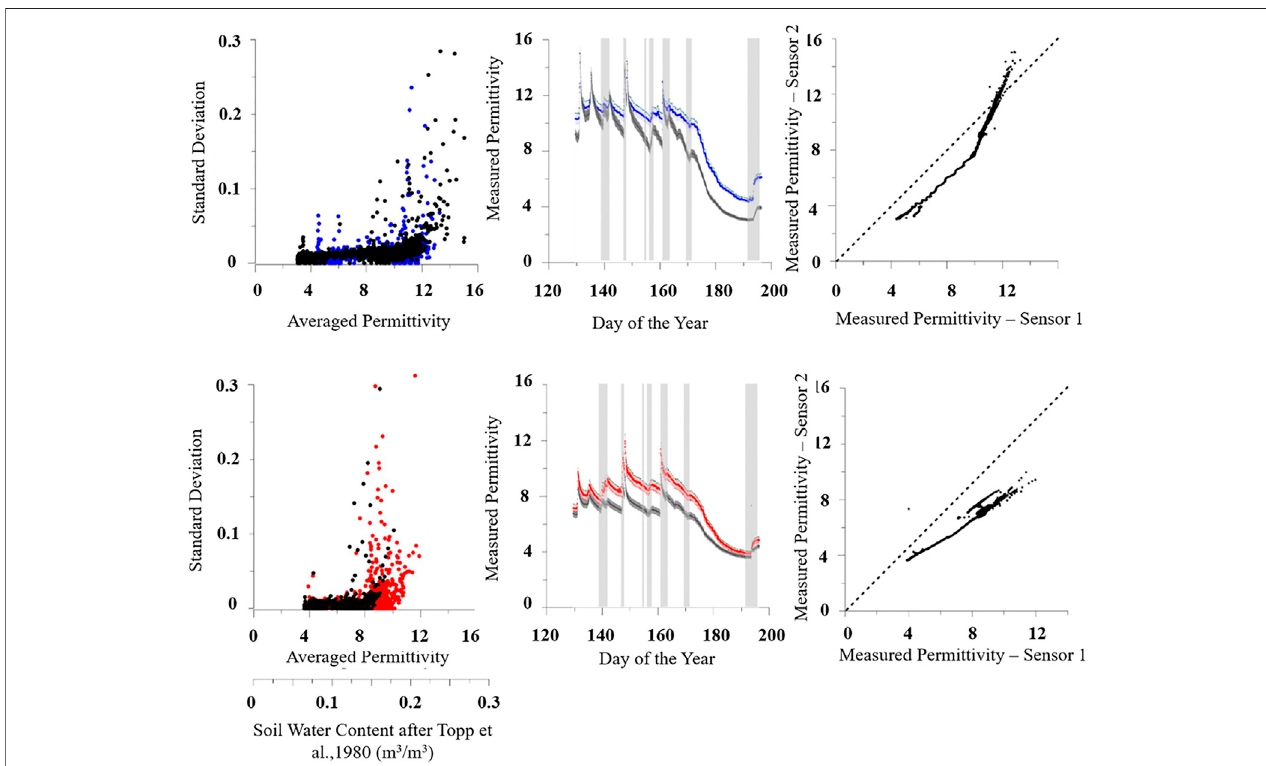
FIGURE 3 | shows two examples of measurement behavior of two similar sensors at two almost identical locations at the same time. Above) Two sensors at a depth of 15 cm below the surface. Higher variability in measured permittivity is observed at this depth, and the test-retest reliability is not seen. While the measured permittivity of the two sensors differs only slightly at the beginning of the measurement, the difference rises with time. However, both sensors show the same response characteristics to rain events (displayed as gray bars). The correlation between these two sensors shows no satisfying consistency compared to the ideal consistency(dottedlightgraylinewithuncertaintyranges-below).Twosensorsatadepthof45 cmbelowthesurface.Atthisdepth,alimitedpermittivityrangeandtest- retestreliabilityareobservedduetoonlyminorchanges.Thedifferenceinmeasuredpermittivitybetweenthesesensorsissmallanditisassumedthatthesetwosensors are consistent because they are very close to the ideal behavior.